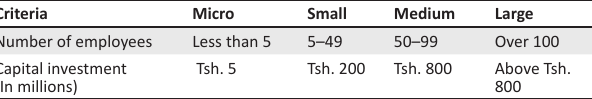
TABLE 6: Republic of Tanzania’s definition of small